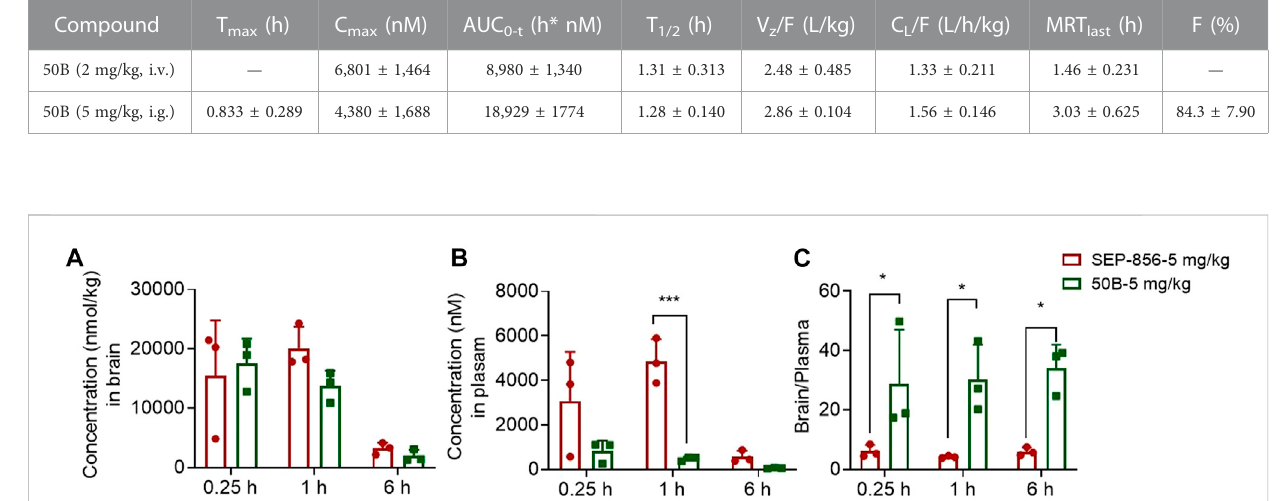
TABLE 1 Pharmacokinetics of 50B in male rats. Compound